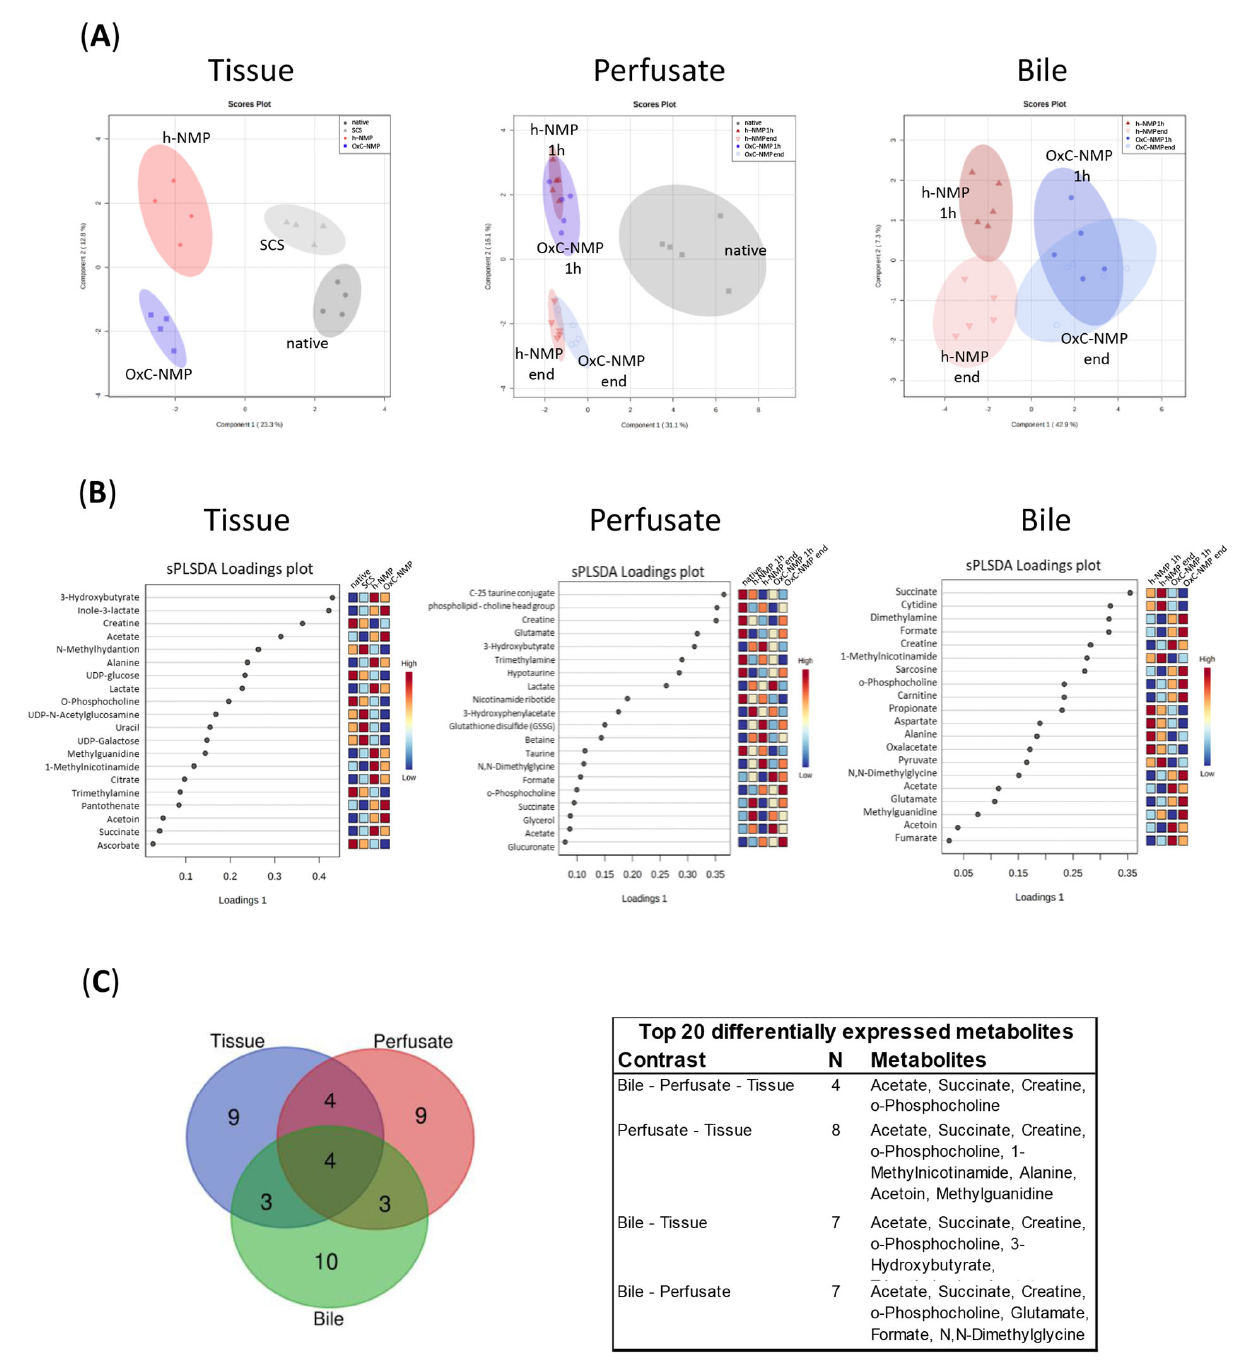
Figure 2. Normothermic machine perfusion (NMP) metabolic profiling: unsupervised analysis of tissue, perfusate, and bile samples . ( A ) sPLS ‐ DA score plots of liver tissue, bile, and perfusate group separation; liver: Native—dark grey dots, SCS—light grey triangles, h ‐ NMP—red rhombus, OxC ‐ NMP—blue triangle. Bile and perfusate: Native—dark grey squares, h ‐ NMP 1h—full red upwards triangles, h ‐ NMP end—empty red downwards triangles, OxC ‐ NMP 1h—full blue dots, OxC ‐ NMP end—empty light blue circles. ( B ) sPLS ‐ DA loadings plot with the top most significant metabolite changes observed in the liver tissue, bile, and perfusate analyses. ( C ) Venn diagram and corresponding table showing the top 20 differentially expressed metabolites in each of the analyzed biological samples and their distribution across tissue, perfusate, and bile specimens.